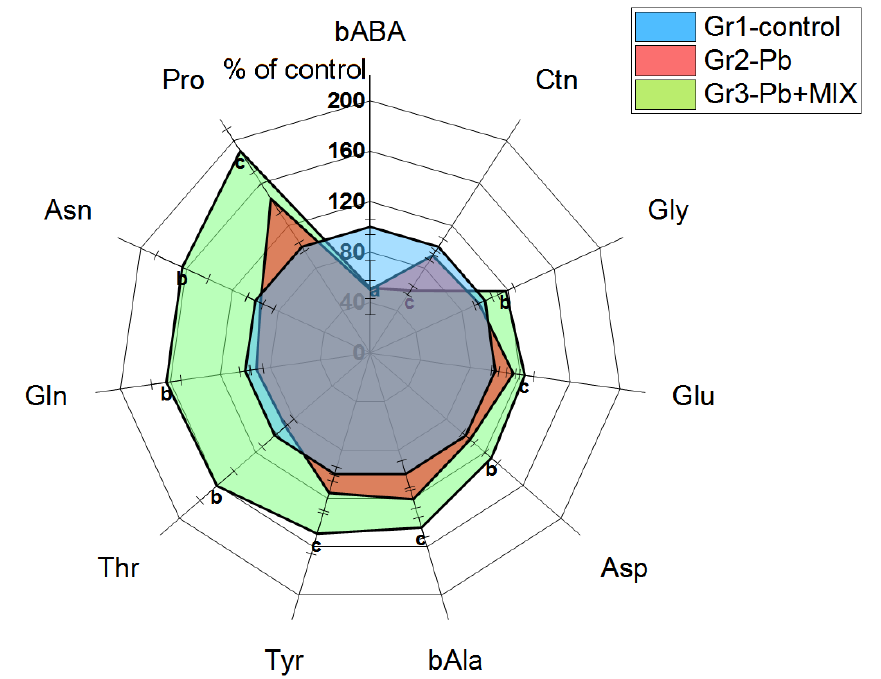
Figure 3. The changes of the biomarkers evaluated in spleen ( n = 6; a indicates statistically significant differences between control and Group 2; b indicates statistically significant differences between Group 3 and Group 2; c indicates statistically significant differences between Group 3 and the control group). The results correspond to the mean values (±SE), p < 0.05.